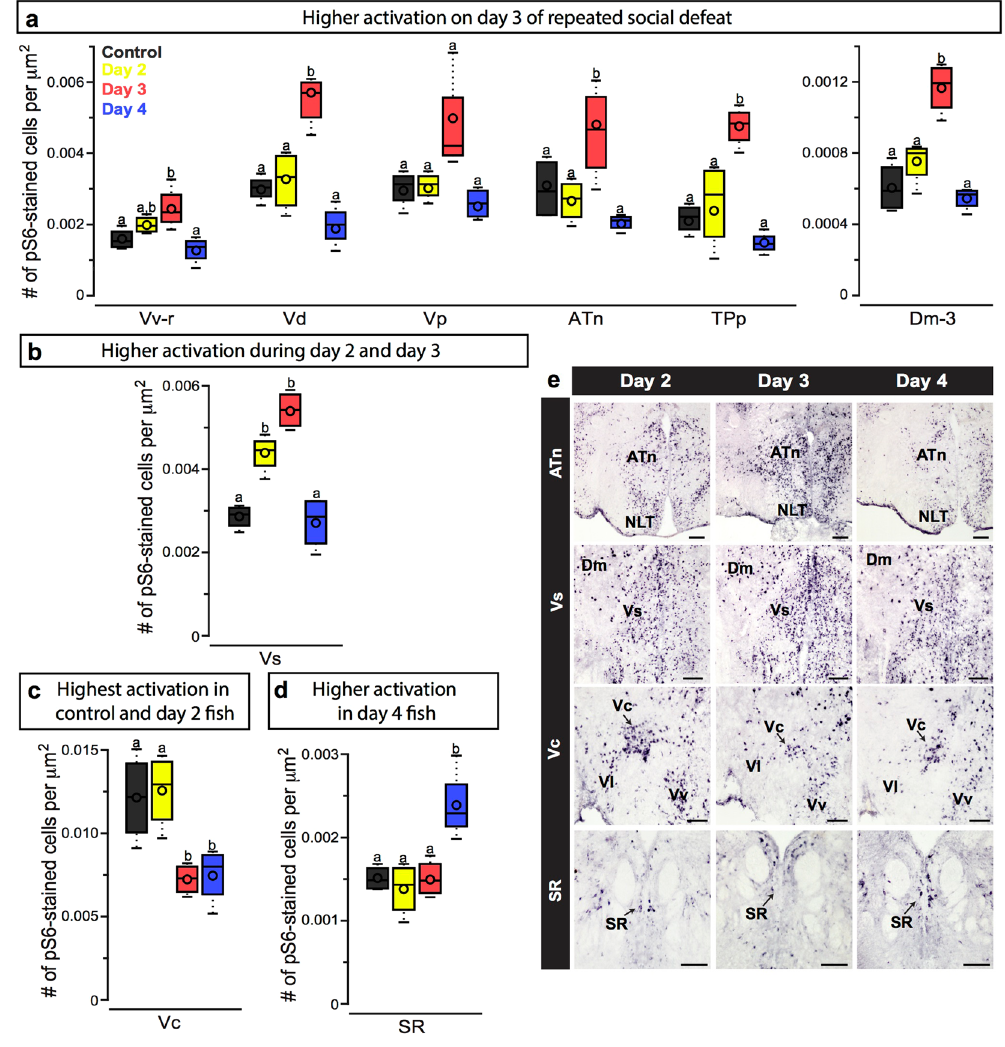
Figure 4. Node by node approach to examine neural activation levels in fish displaying different coping behaviours. ( a ) pS6-stained cell density (i.e. neural activation) in the Vv-r, Vd, Vp, ATn, TPp, and Dm-3 was highest in fish collected after 3 days of repeated social defeat (red). ( b ) In the Vs, fish collected after day 2 (yellow) and day 3 had higher neural activation than control (grey) and day 4 (blue) fish. ( c ) Control fish and those collected on day-2 had higher activation in the Vc compared to fish collected after 3 and 4 bouts of defeat. ( d ) Neural activation in the SR was higher in fish collected after 4 days of defeat when compared with those collected after only 2 or 3 days of defeat. ( e ) Representative photomicrographs of pS6 staining in the ATn, Vs, Vc, and SR from fish collected after 2 (left), 3 (middle), and 4 (right) days of repeated social defeat. Tukey’s box plots were used to plot the data: median is represented by a line and mean by an open circle within the box, the box extends to the furthest data points within the 25 th and 75 th percentile, and whiskers extend to the furthest data points not considered outliers. Different letters represent statistical significance at P < 0.05. N = 4 for all groups. See text for abbreviations. Scale bars in E represent 100 μ m for the ATn and Vs panels and 50 μ m for the Vc and SR